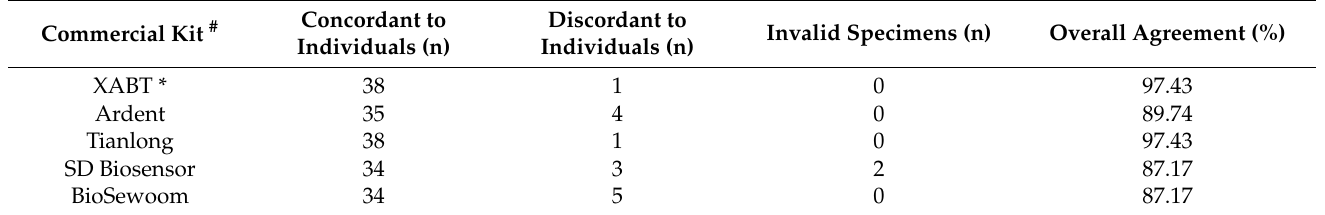
Table 2. Pooling-of-four method in different schemes. Table 3. Performance of commercial detection kits using pooled heat-treated saliva specimen as the RT-qPCR